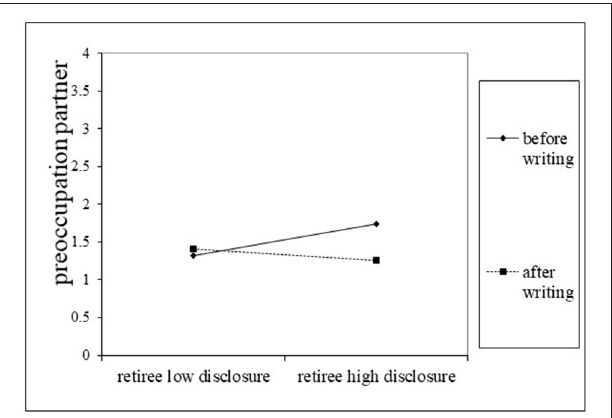
FIGURE 3 | Moderation daily retiree disclosure before and after writing on partner preoccupation. High–low retiree disclosure estimates are unstandardized betas of double intercept (retiree/partner) APIM multilevel models controlled for gender and